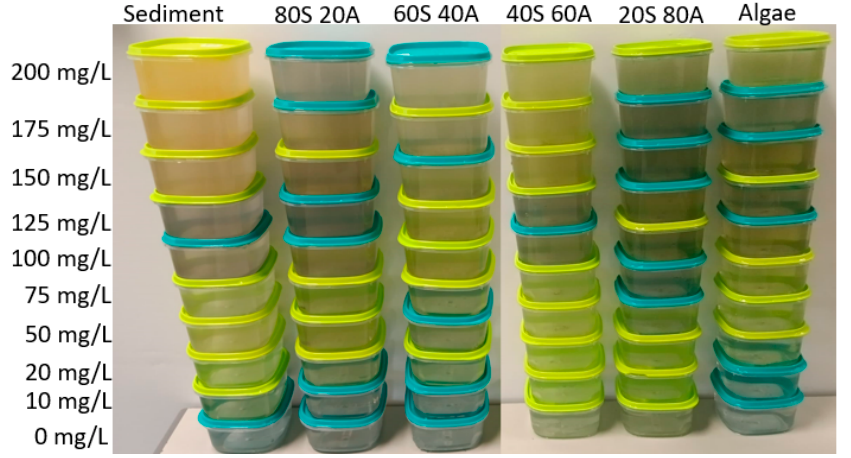
Figure 4. Samples